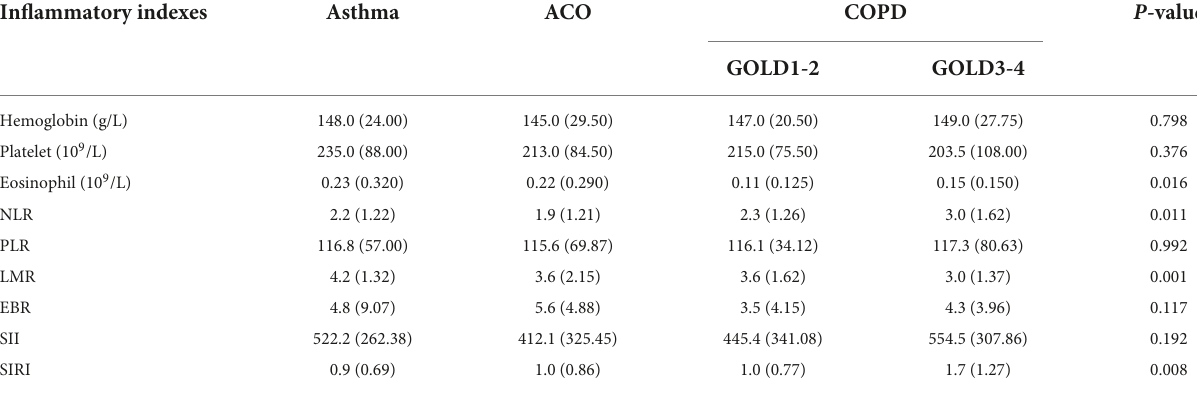
TABLE 2 Inflammatory index levels among asthma, ACO, and COPD.